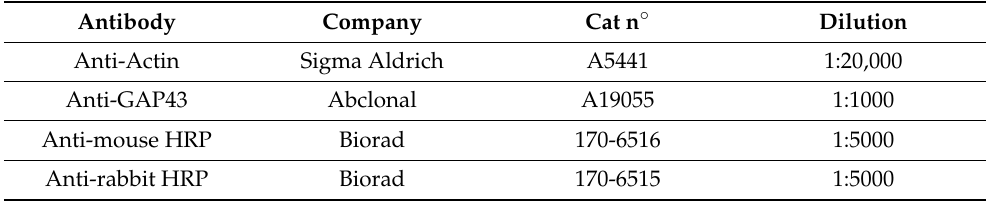
Table 1. List of antibodies used for